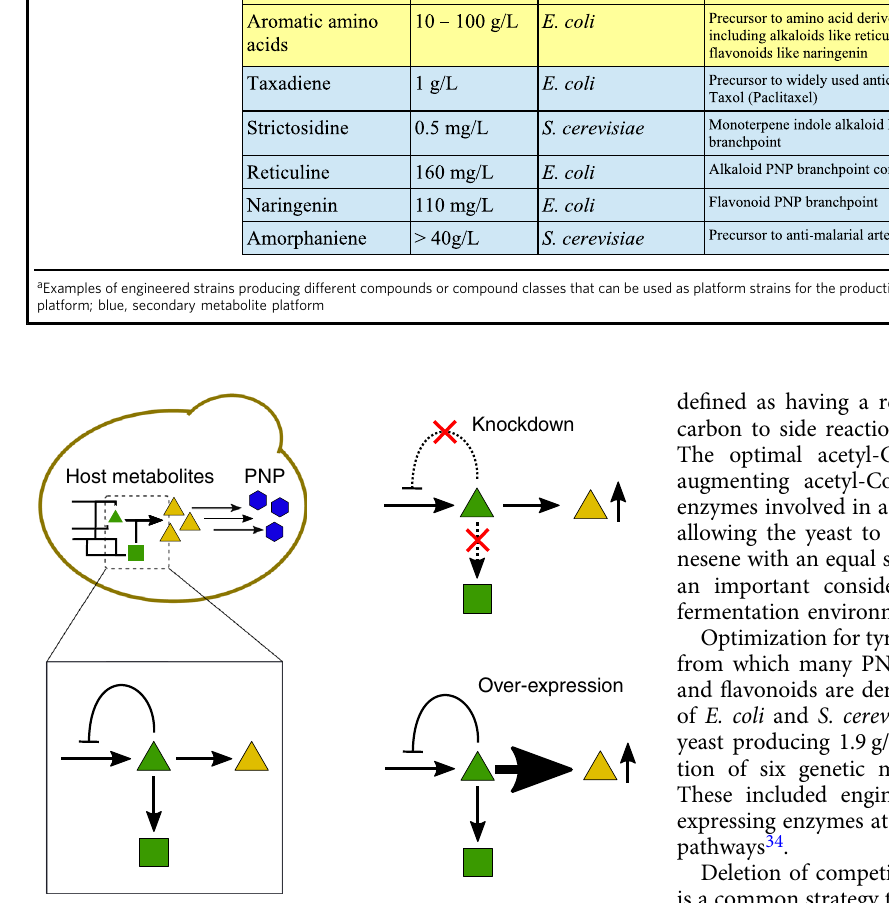
Fig. 2 Common host engineering strategies to increase titer of a PNP precursor compound. Yellow triangles, core metabolite platform; blue hexagons, secondary metabolite